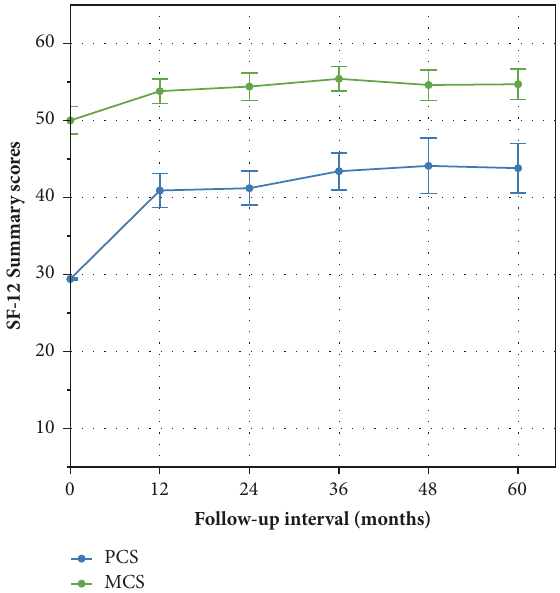
Figure 1: Time course of results for the physical component summary (PCS) and mental component summary (MCS) scores through 5 years of follow-up. Results presented as mean (95%